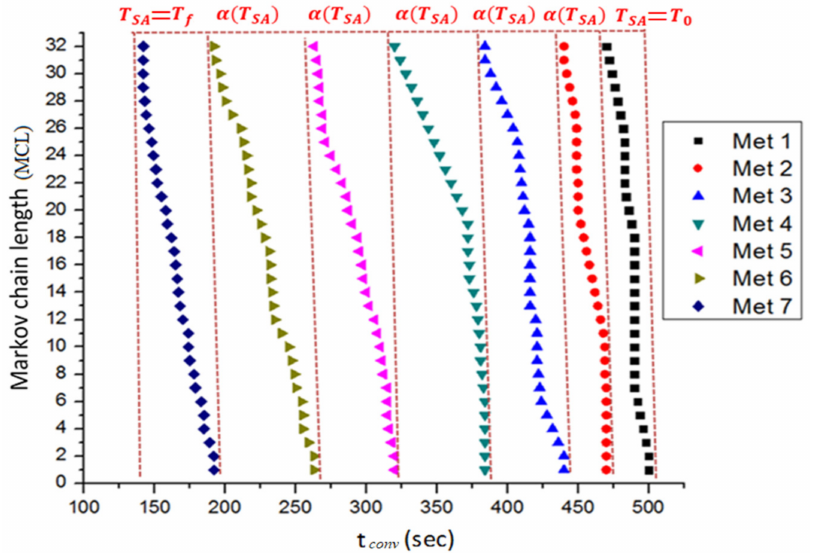
Figure 8. Convergence time of the Driven-Cavity problem with